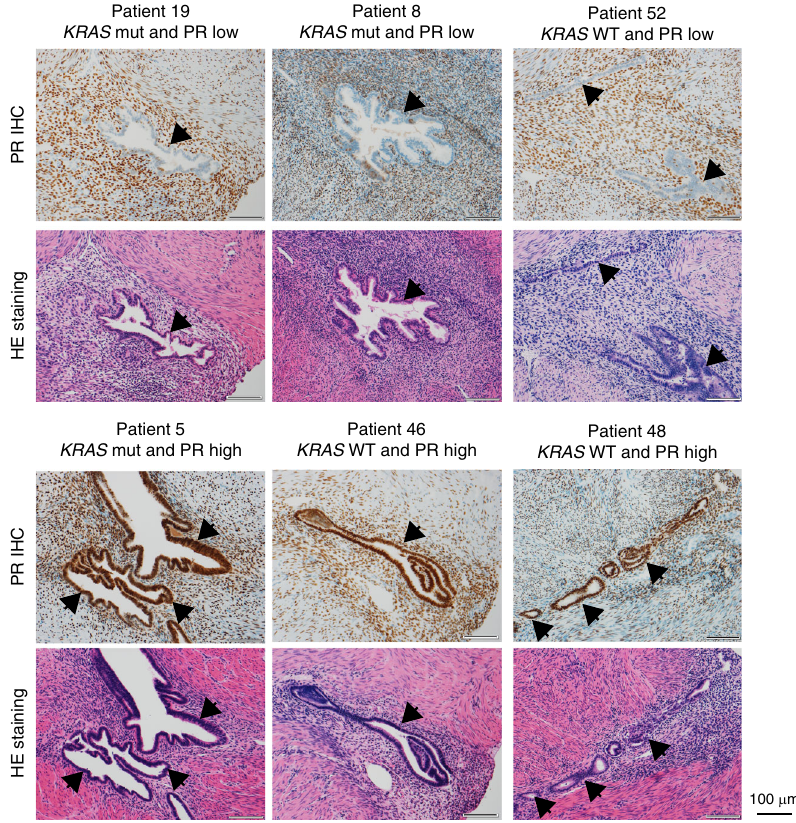
Fig. 7 Downregulation of progesterone receptors (PRs) in KRAS -mutated adenomyosis as assessed by immunohistochemical (IHC) analyses. Representative photomicrographs of (upper) IHC of PR and (lower) HE staining of adenomyotic lesions from the indicated patients. Arrowheads, epithelial component. Scale bars, 100 µ